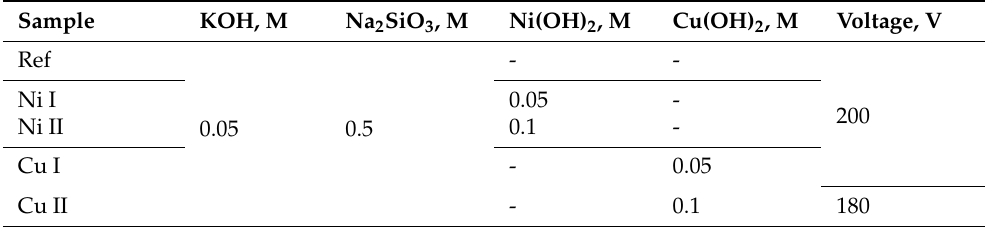
Table 1. Sample code clarification and electrolytic bath compositions.